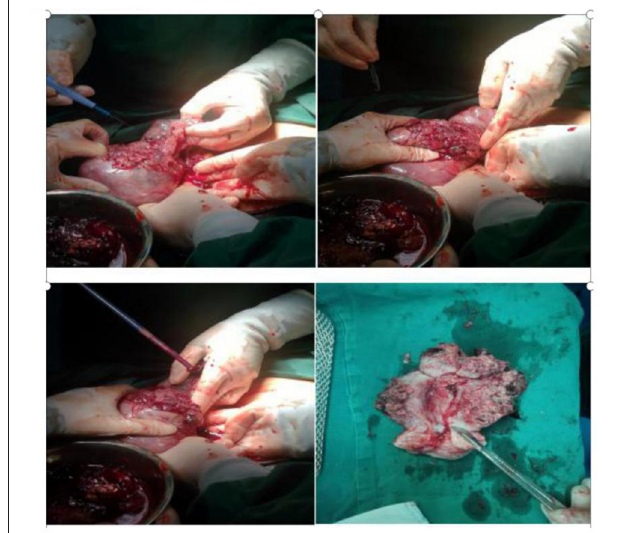
FIGURE 2 | Intraoperatively, the uterus was ruptured, with a breach of about 10cm, leaving a grape-like tissue. Incision of uterus, the lesion invaded the entire layer of the uterus but not into the cervix and endometrium.